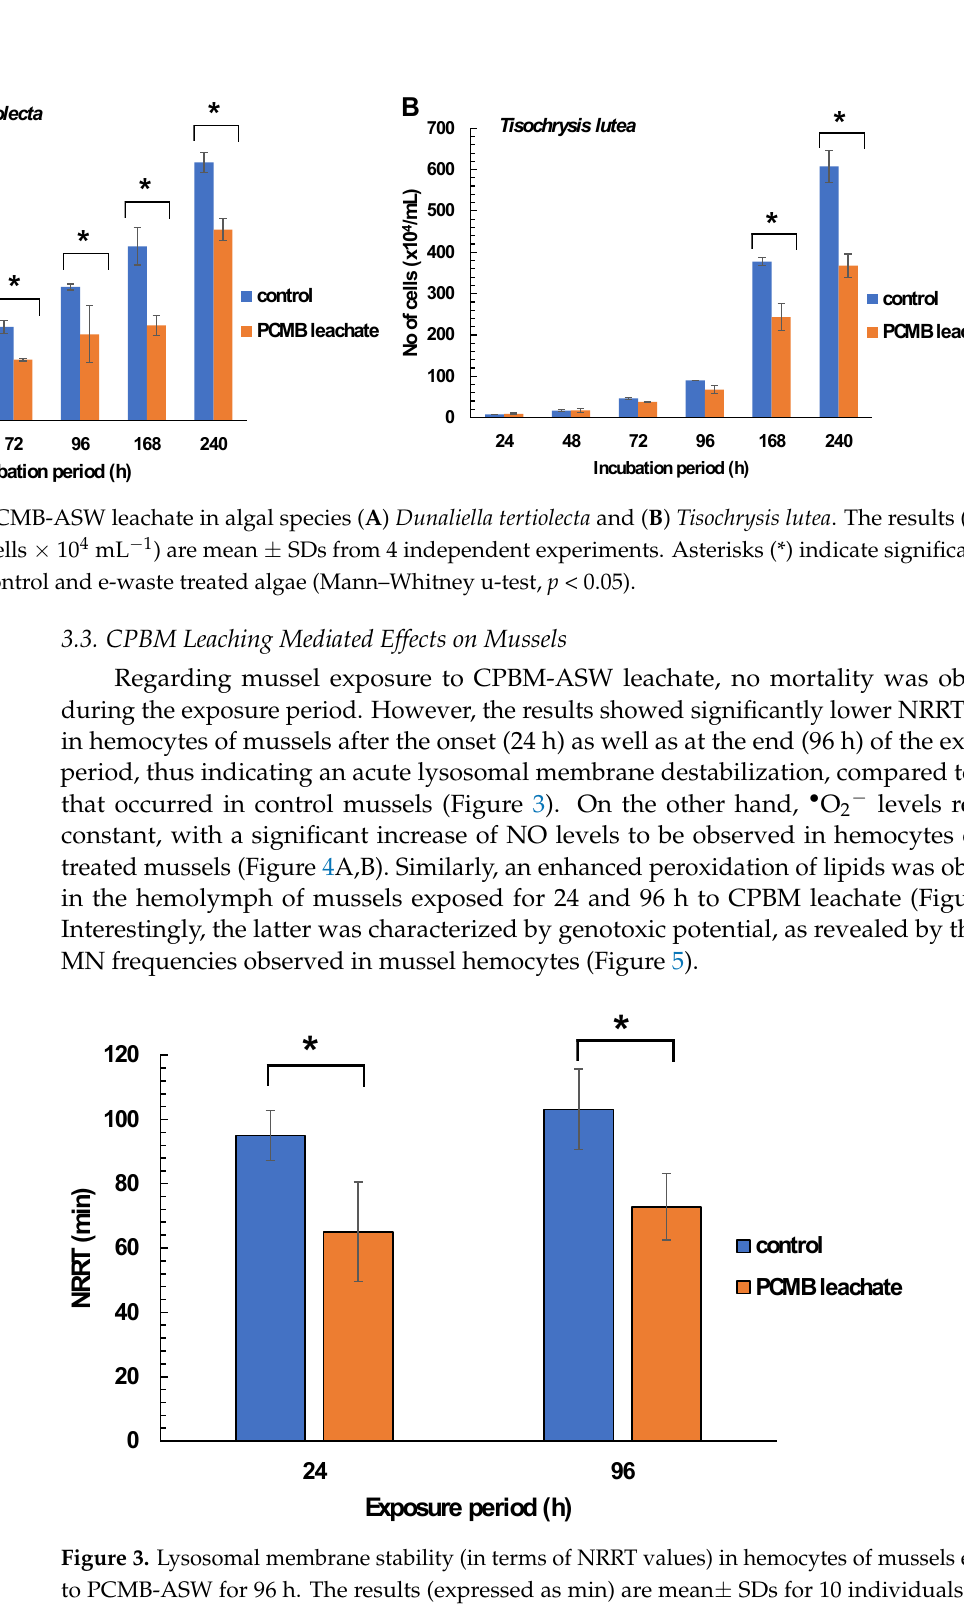
Figure 4. Determination of ( A ) superoxide anions ( . O 2 − ), ( B ) nitric oxides (in terms of NO 2 − ), and ( C ) lipid peroxidation (in terms of MDA equivalents) in hemocytes/hemolymph of mussels exposed to PCMB-ASW for 96 h. The results (expressed as OD 620 nm mg protein − 1 , μ mol NO mg protein − 1 , and nmol MDA mg protein − 1 , respectively) are mean ± SD from 3 different measurements (each measurement was performed in duplicate) in all cases. Asterisks (*) indicate significant difference from the respective control. Values that share the same letter differ from each other (Mann–Whitney u-test, p < 0.05).